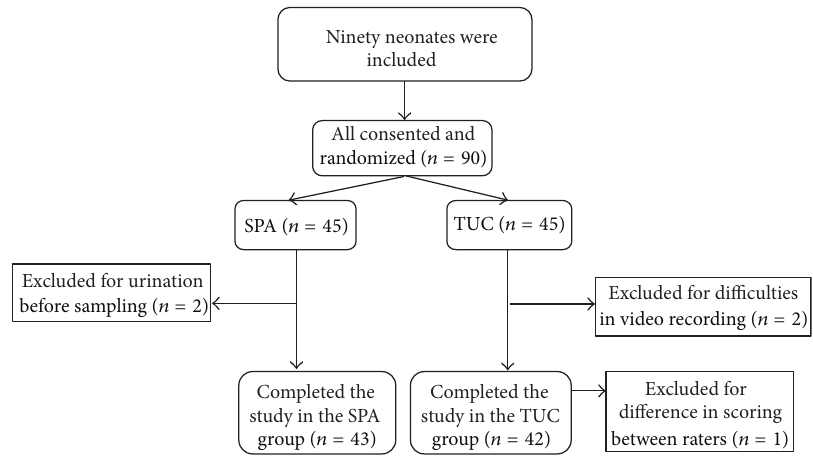
Figure 1: Flow diagram of the study participants.